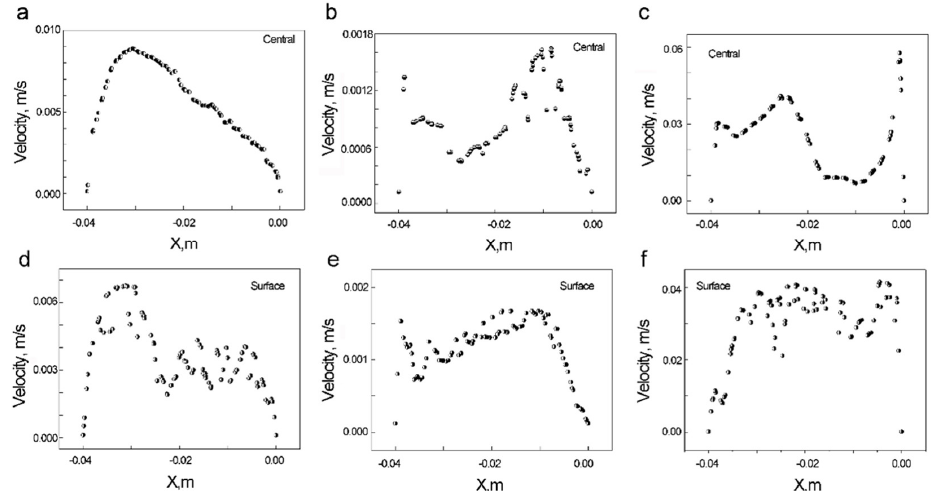
Figure 6. Velocity profiles at the front of solidification interface: ( a ) No TMF (Central); ( b ) I = 8 A, f = 50 Hz (Central); ( c ) I = 25 A, f = 50 Hz (Central); ( d ) No TMF (Surface); ( e ) I = 8 A, f = 50 Hz (Surface); ( f ) I = 25 A, f = 50 Hz (Surface).